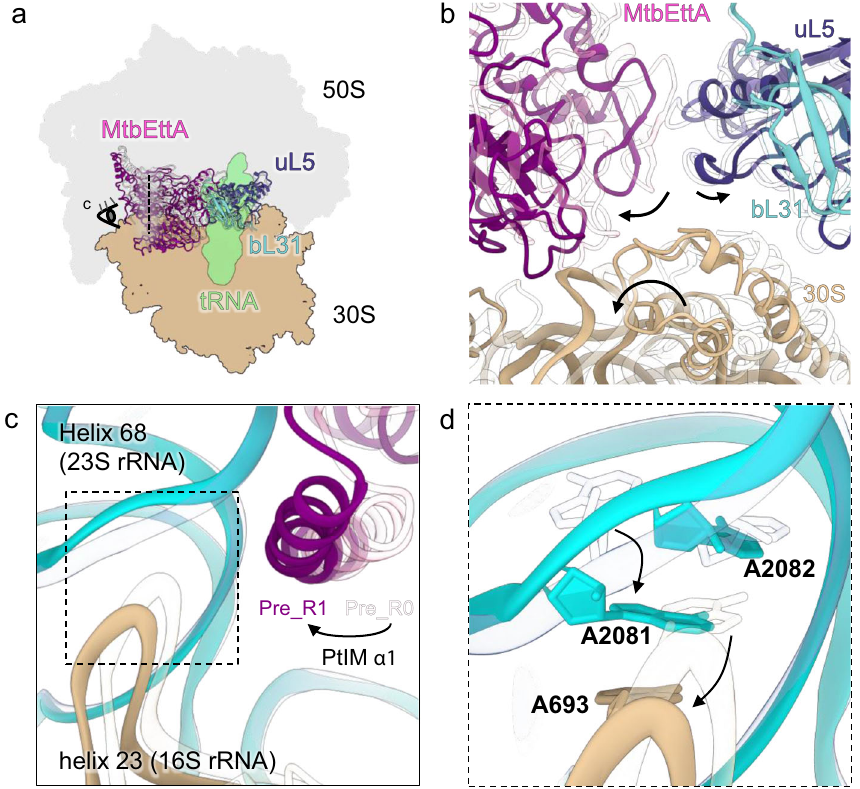
Fig. 3 Remodeling of the Mtb 70SIC upon binding MtbEttA in the Pre_R1 state. a Models of the 70SIC-MtbEttA complex in the Pre_R0 (transparent) and Pre_R1 (solid color) states are superimposed based on the 23S rRNA. 50S, 30S, and tRNA for the Pre_R0 state are shaded in the background. MtbEttA, bL31, and uL5 are shown as models. b A zoom-in view at the split interface. Directions of movements for MtbEttA, 30S, bL31, and uL5 are indicated by black arrows. c Rearranged 50S-30S interface in the Pre_R1 state. Direction and position of the view are indicated by the eye cartoon and a dashed vertical line in ( a ). d A close-up view of the rearranged base stacking in the Pre_R1 state is shown, with arrows indicating movements of corresponding nucleotides from the Pre_R0 state